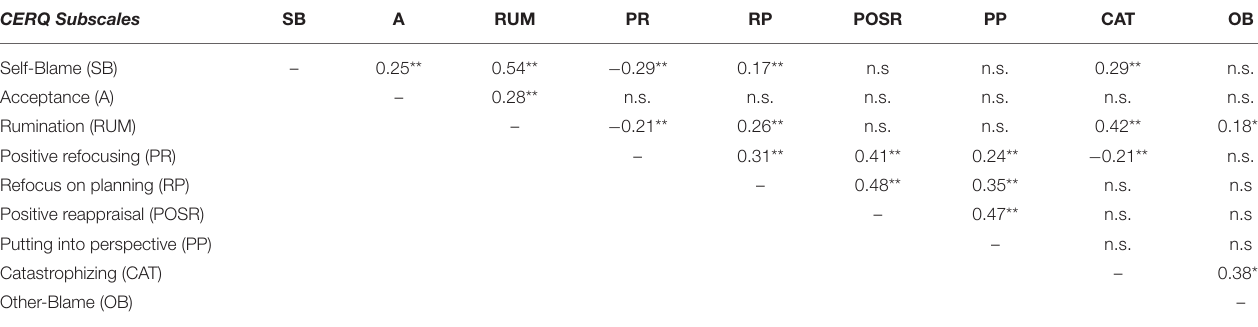
TABLE 3 | Intercorrelations among the CERQ Subscales.